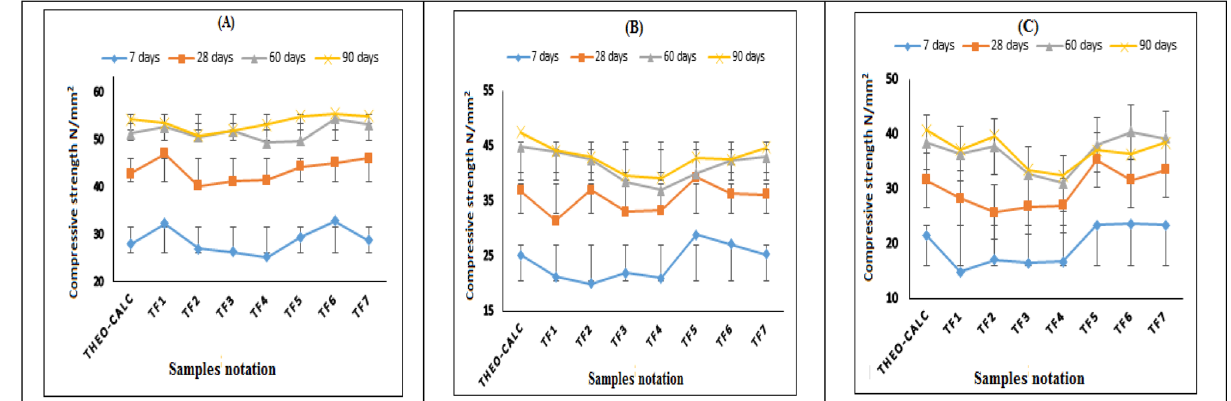
Figure 6. Compressive strength values at different substitution ratios for Tuff samples; ( A ) At substitution ratio of 20%, ( B ) At substitution ratio of 30% and ( C ) At substitution ratio of